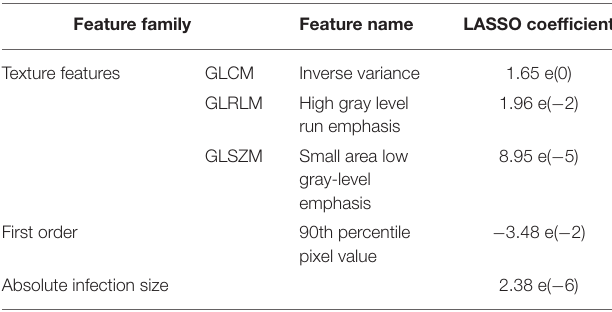
TABLE 2 | U-Net-based model analysis. TABLE 3 | Selected top